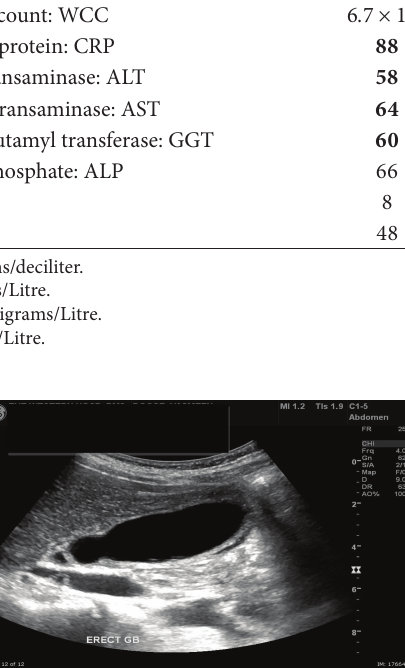
Figure 1: Gallbladder ultrasound showing a distended gallbladder, some pericholecystic fluid, and no